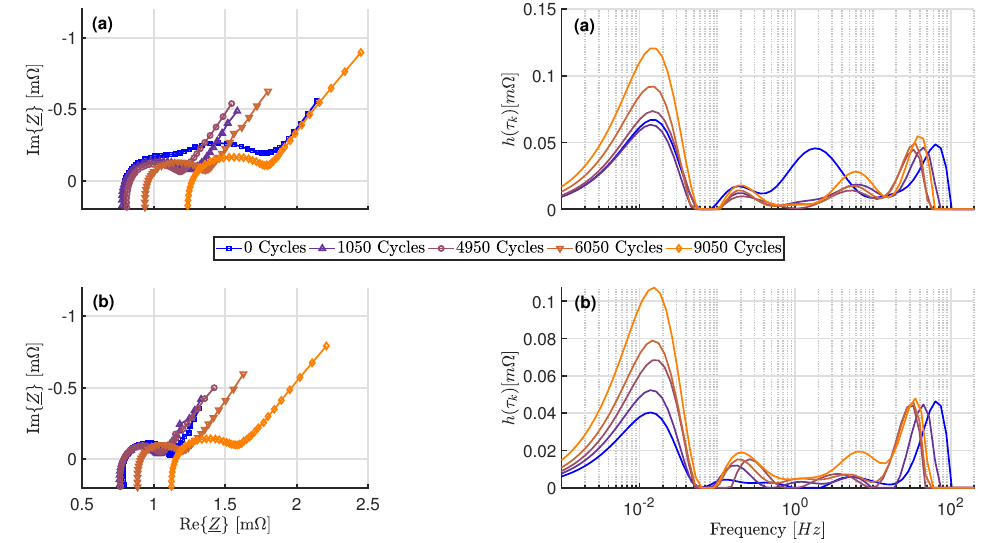
Figure 7. Measured impedance spectra and corresponding DRTs over aging ( a ) At 20% SOC; ( b ) At 80%